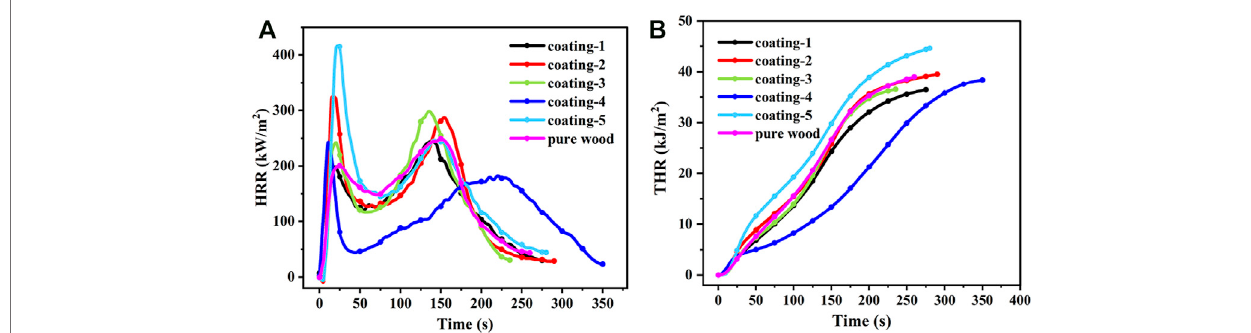
FIGURE 5 | The HRR (A) curves and THR (B) curves of the coated and pure wood.